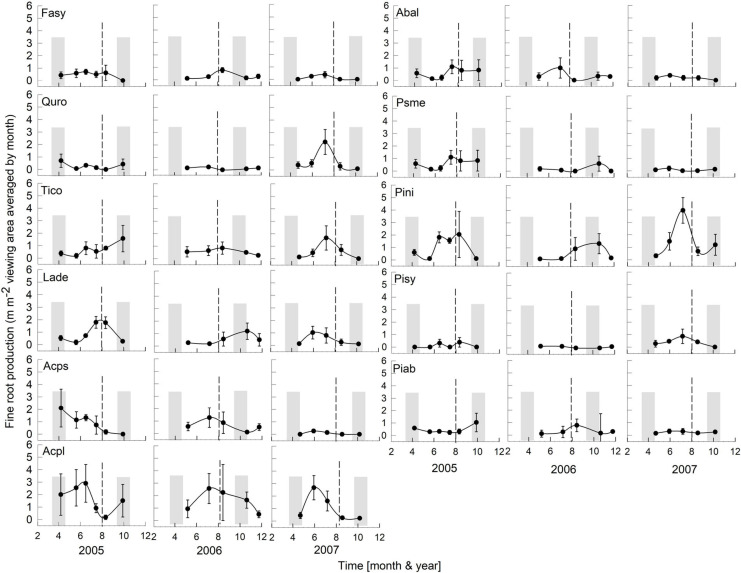
Seasonality of monthly averaged fine-root length production ( ± SE) of 11 temperate tree species growing in a common garden for the years 2005–2007. Species are abbreviated with the first two letters of their genus and species name. Gray bars indicate observed bud break and leaf flush (mid-March to mid-May) as well as leaf fall (mid-September to end of October) of each year. The dashed line is the center of the observed growing season (June–October). Each plot was weighted equally in calculating the seasonal patterns (3–6 plots per species; see section “Materials and Methods” for details). Root production data in this figure were adjusted to 28 day intervals to account for uneven image recording dates within a year. The first data point in each year assumed that root growth did not occur in December or January (see section “Materials and Methods”).